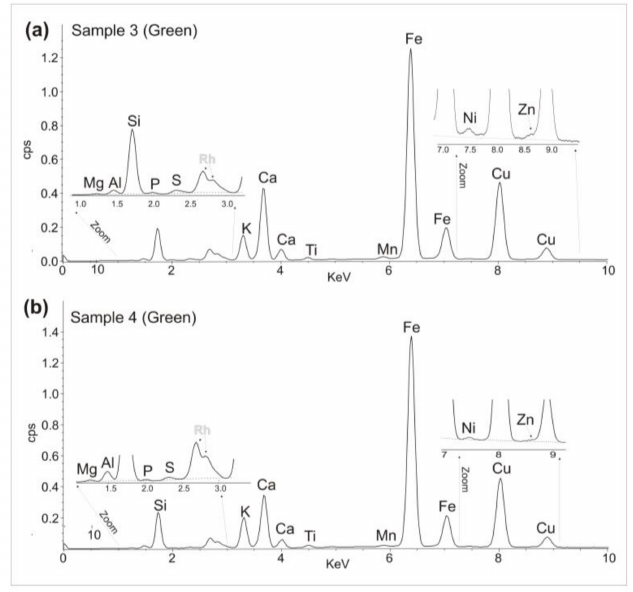
Figure 4. P-XRF spectra of the green painted surfaces of Samples 3 ( a ) and 4 ( b